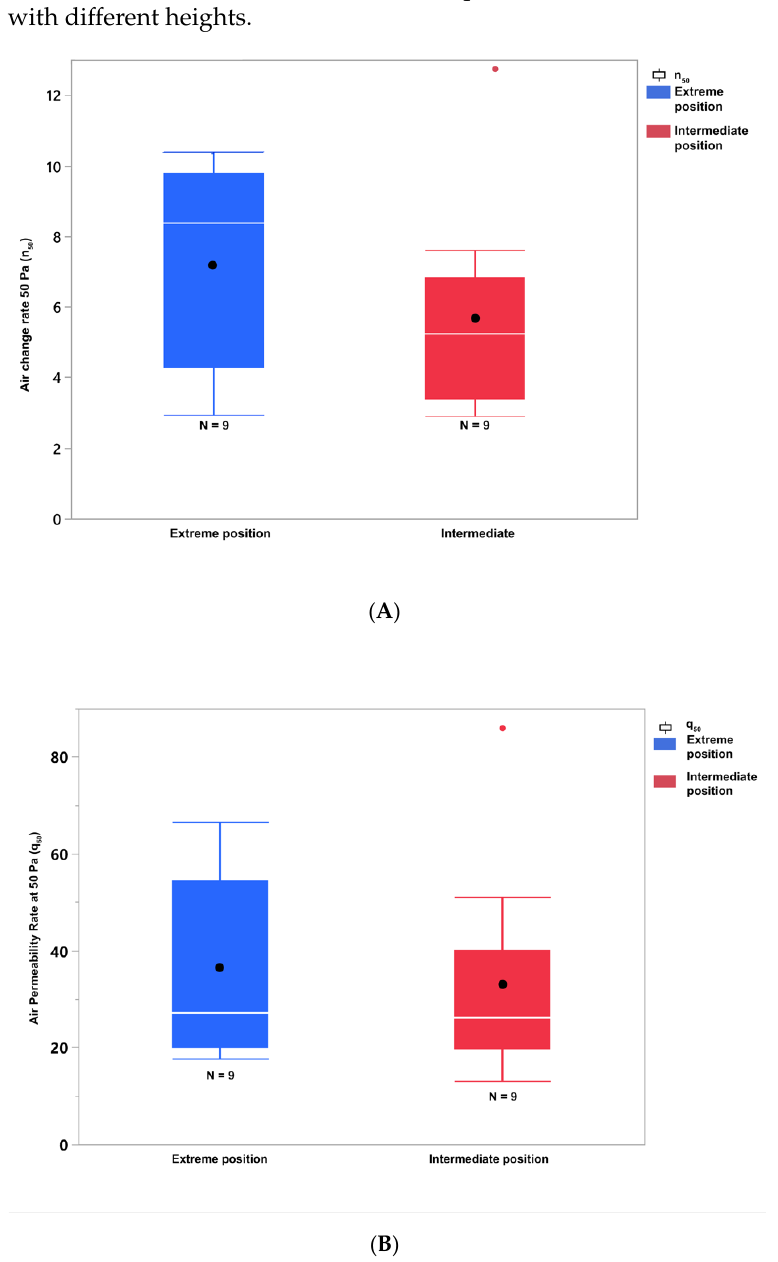
Figure 8. Box and whisker plots showing the distribution of ( A ) n 50 and ( B ) q 50 for dwellings in extreme and intermediate positions (black dots show the mean value).